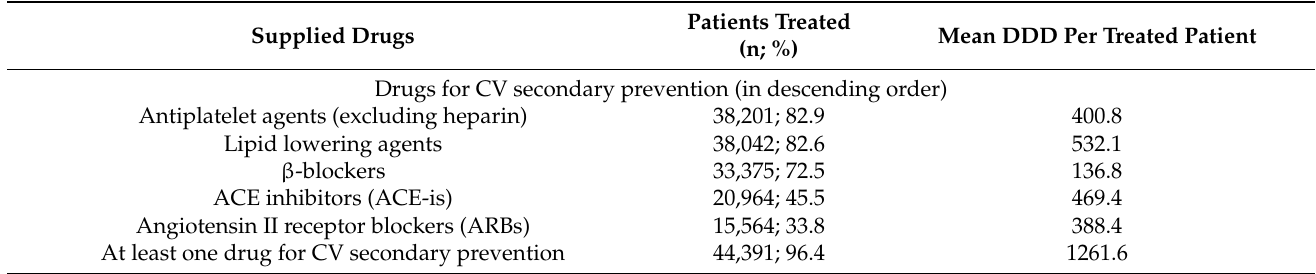
Table 2. Pharmacological treatments supplied to patients with CAD and eligible for cardiovascular (CV) secondary prevention drugs during the one-year